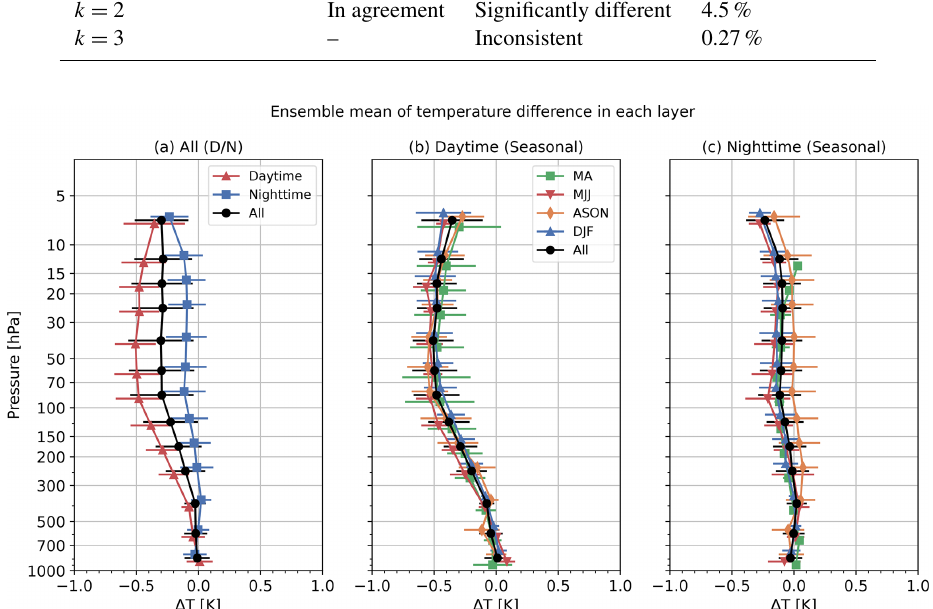
Figure 18. (a) Profiles of ensemble mean temperature differences (iMS-100-GDP minus RS92-GDP) with standard deviations (error bars) for all seasons combined. Red, blue, and black lines represent daytime, nighttime, and all data, respectively. Points are vertically shifted for ease of viewing. Panel (b) is as per panel (a) but represents seasonal profiles for daytime data. The green, red, orange, blue, and black lines represent MA, MJJ, ASON, DJF, and all seasons, respectively. Panel (c) is as per panel (b) but for nighttime